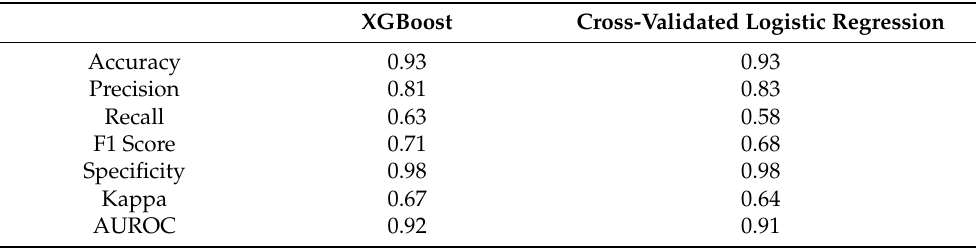
Table 3. Model Performance Metrics Using Test data *; Potentially Inappropriate NSAIDs Use in Older Adults with Osteoarthritis; Optum Clinformatics Data Mart 2015–2016.